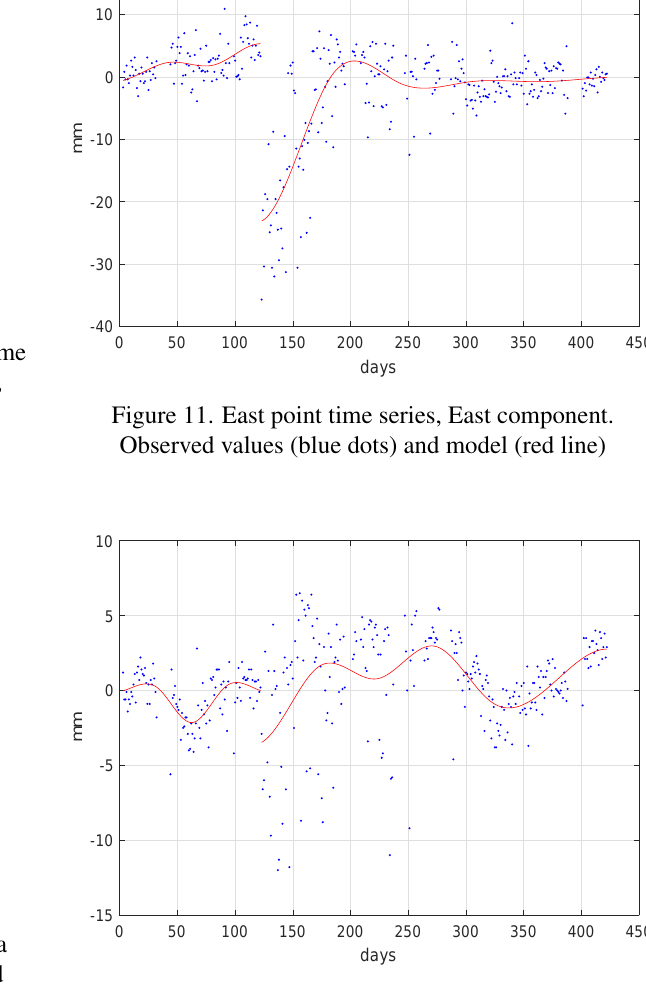
Figure 12. East point time series, North component. Observed values (blue dots) and model (red line)